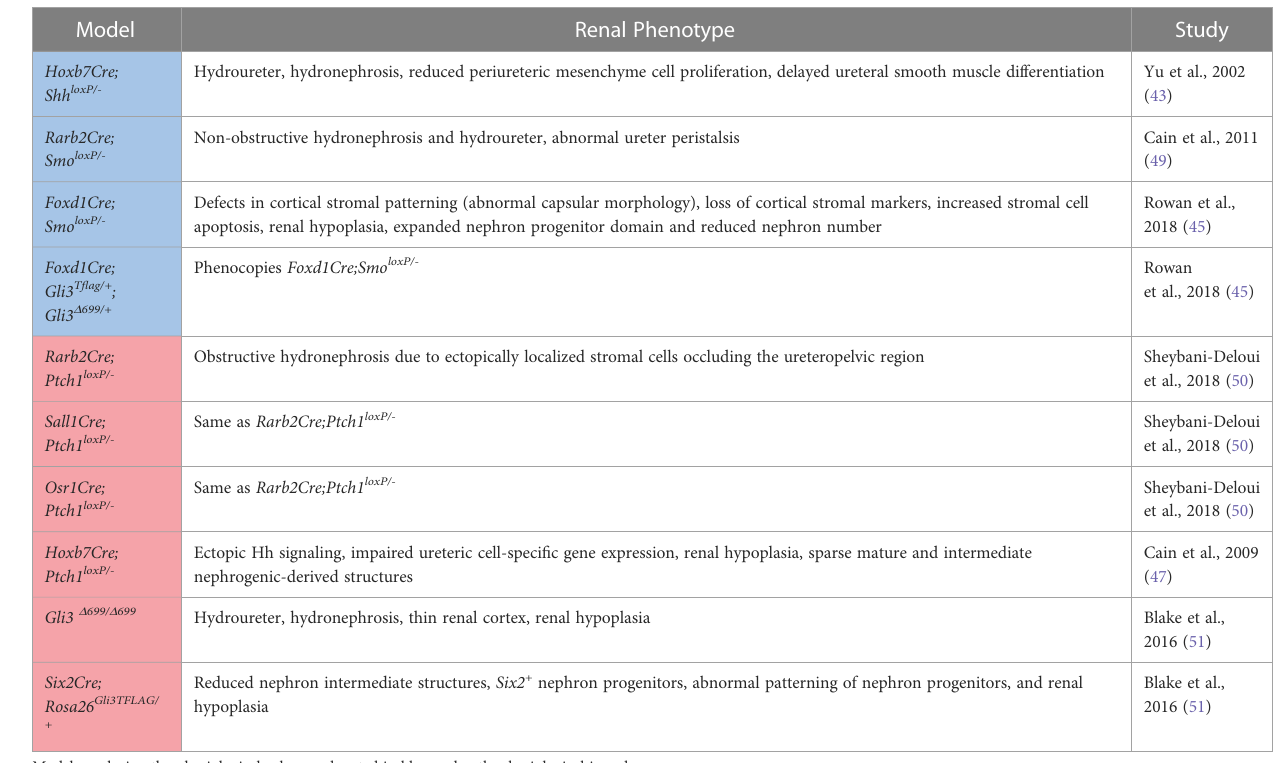
TABLE 1 A summary of the mouse models used to investigate the physiological and pathophysiological roles of Hedgehog signaling in the developing kidney along with the associated phenotypes.